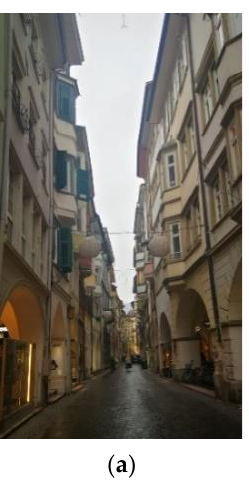
Table 9. Tested adaptation options. T i = Indoor temperature, T e = Outdoor temperature.